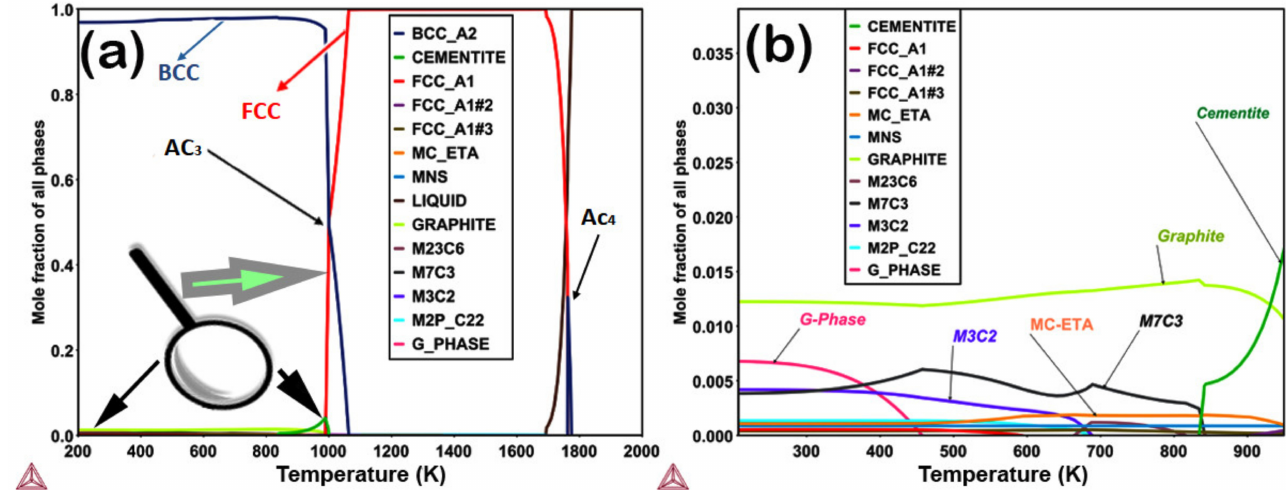
Figure 1. ( a ) Stable phase diagram of SA508 w.r.t to the temperature at 200–2000 K; ( b ) 200–1000 K range temperature area of stable phases (Zoom